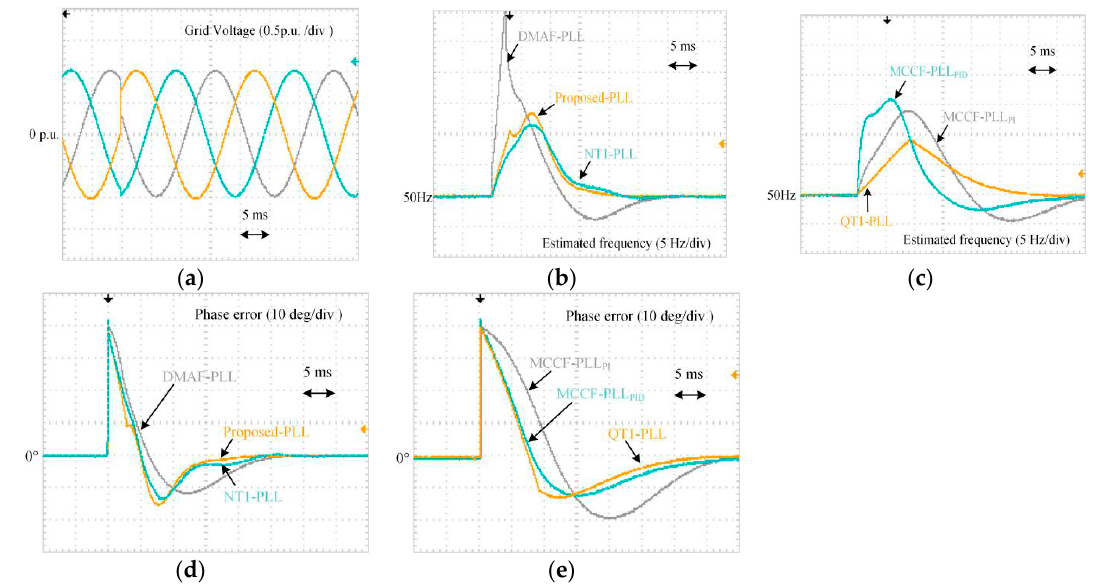
Figure 21. Experimental waveforms under a +40° phase jump: ( a ) Three-phase voltages; ( b , c ) Estimated frequency; ( d , e ) Phase error.